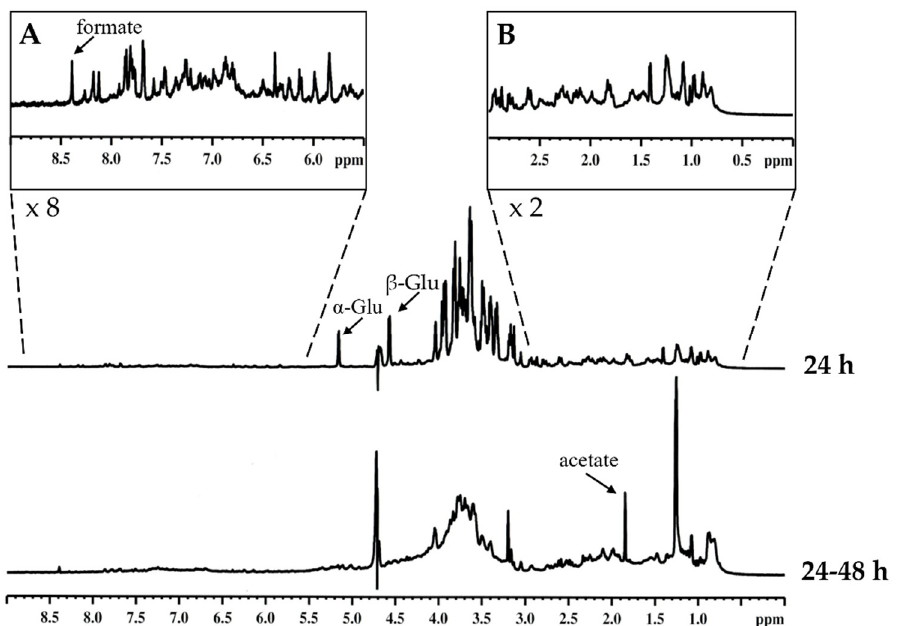
Figure 3. 1 H NMR spectra of maize Nostrano di Storo exudate dissolved in D 2 O at 25 ◦ C. In the upper panel the spectra related to the first 24 h after imbibition are reported; in the lower panel, the second interval of 24 h after replacing medium (24–48 h) is reported. In the insets are presented the magnifications of the high field regions attributable to aromatic/olefinic compounds ( A ) and low field regions attributable to aliphatic compounds ( B ) of the exudate after 24 h of imbibition with the relative magnification power.